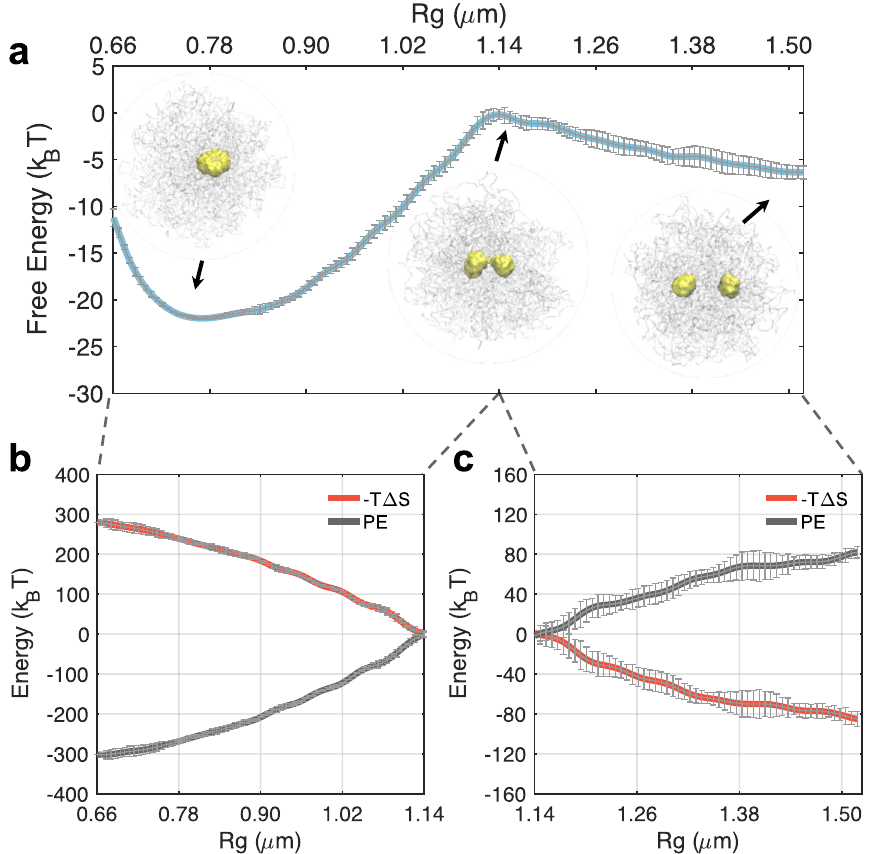
Fig. 3 An entropic barrier hinders droplet coalescence and drives the metastability of a two-droplet state. a Free energy pro fi le as a function of the radius of gyration ( R g ) that effectively measures the distance between two droplets. Energetic (black) and entropic (red) contributions to the free energy pro fi le before ( c ) and after ( b ) the coalescence barrier. Error bars were calculated as standard deviations of the mean using block averaging by dividing the simulation trajectories into fi ve blocks of equal